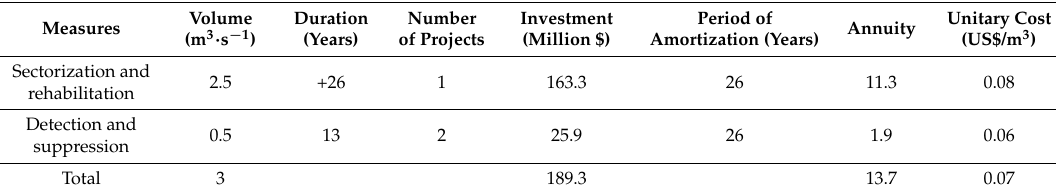
Table 6. Financial assumptions for centralized measures of leak control in Mexico